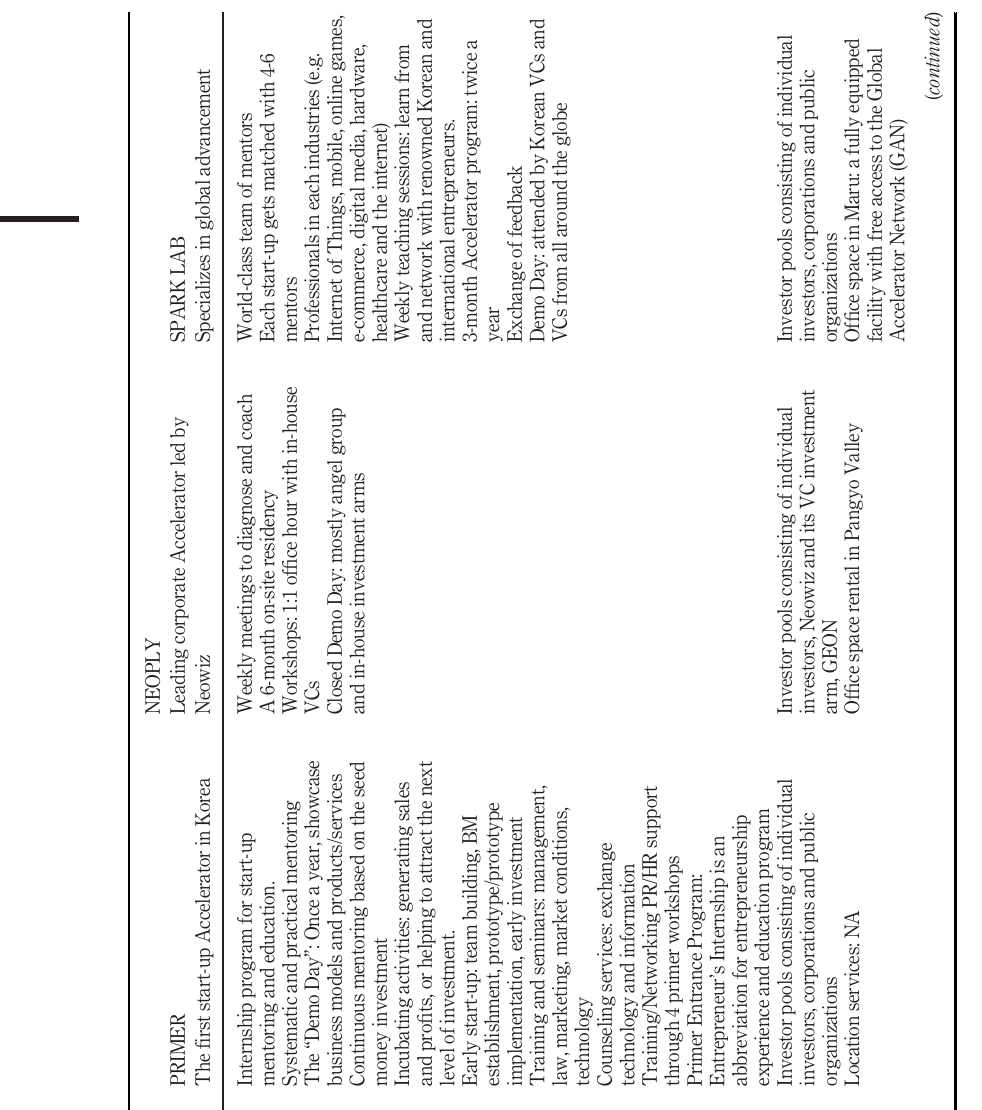
Table III. Accelerators in Korea